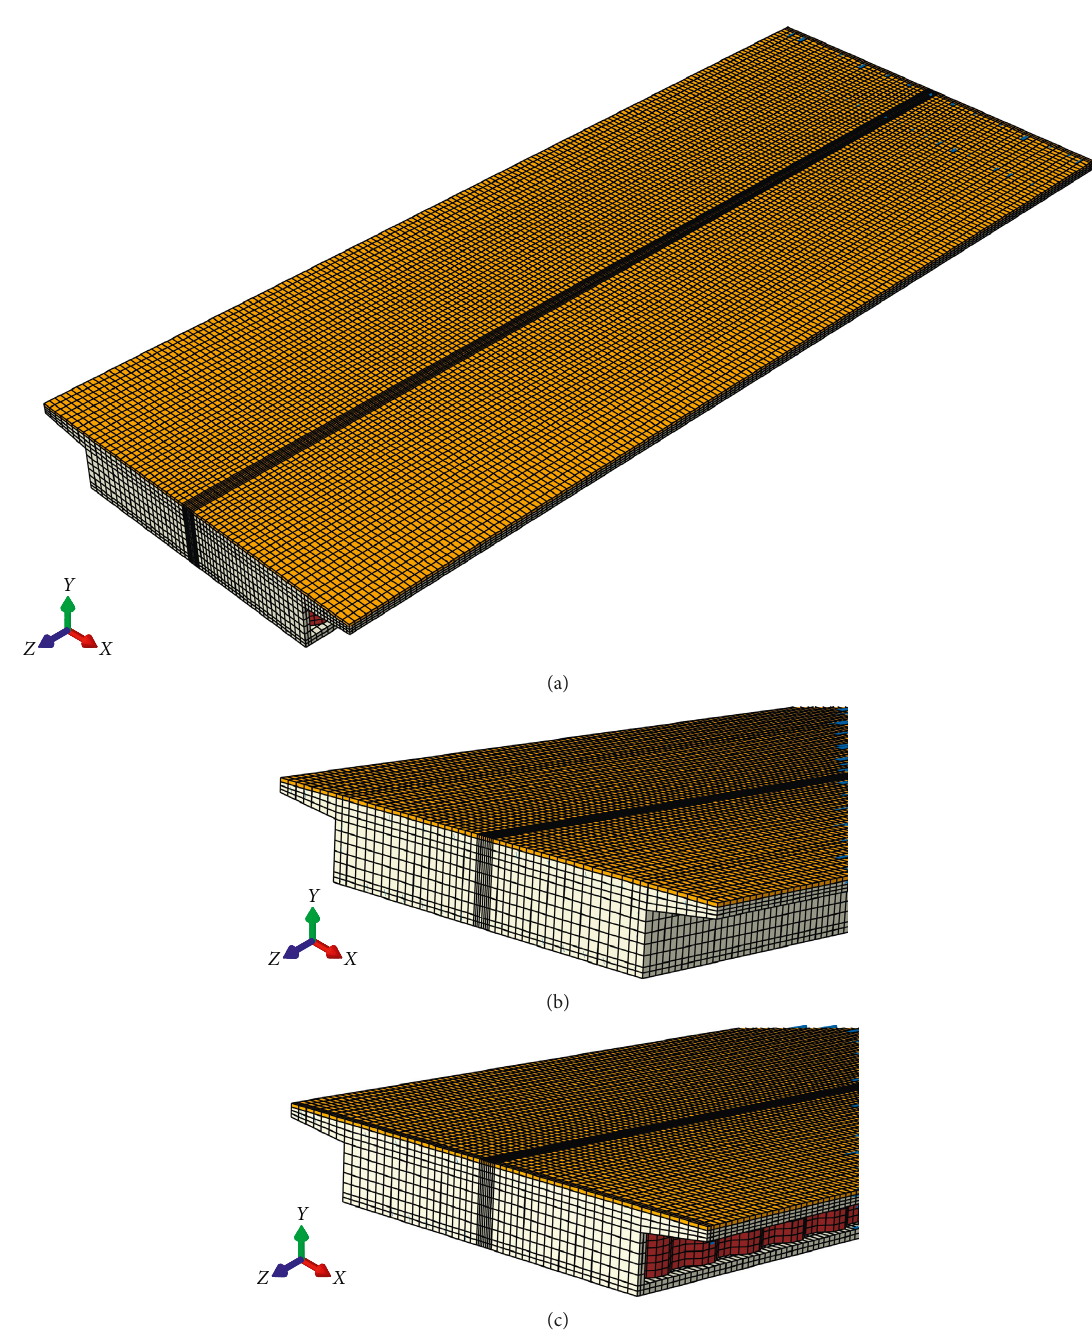
Figure 3: Finite element model of the bridge deck pavement. (a) Finite element model of the whole bridge. (b) Paving model of the concrete web box girder bridge. (c) Paving model of the box girder bridge with corrugated steel